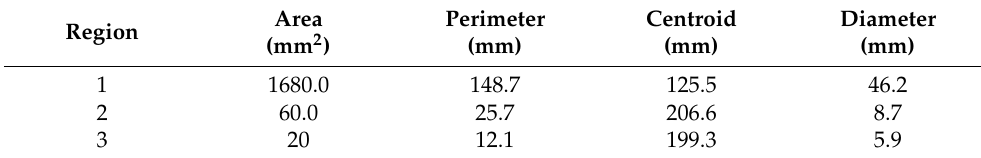
Figure 10. Detection of malignant Sample. ( a ) Input CT Image, ( b ) Pre-processed Output image, ( c ) Histogram Equalised Image Plot, ( d ) Histogram Equalised Image, ( e , f ) Segmentation image, ( g ) Classification result. Table 5. Parameter calculation of nodules.